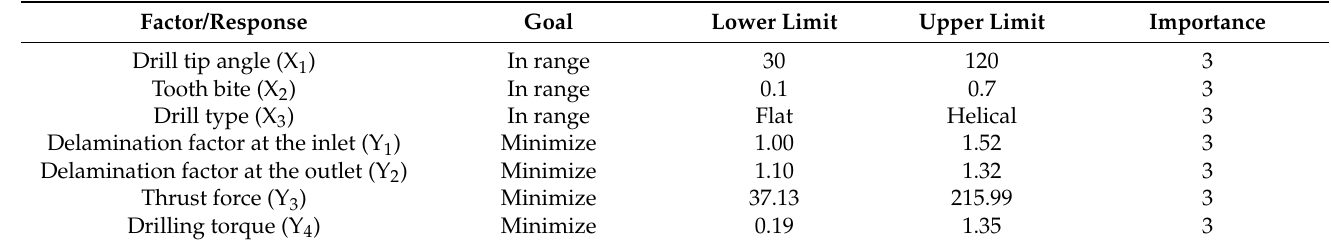
Table 9. Criteria for different factors and responses in optimization of wood particleboard drilling.